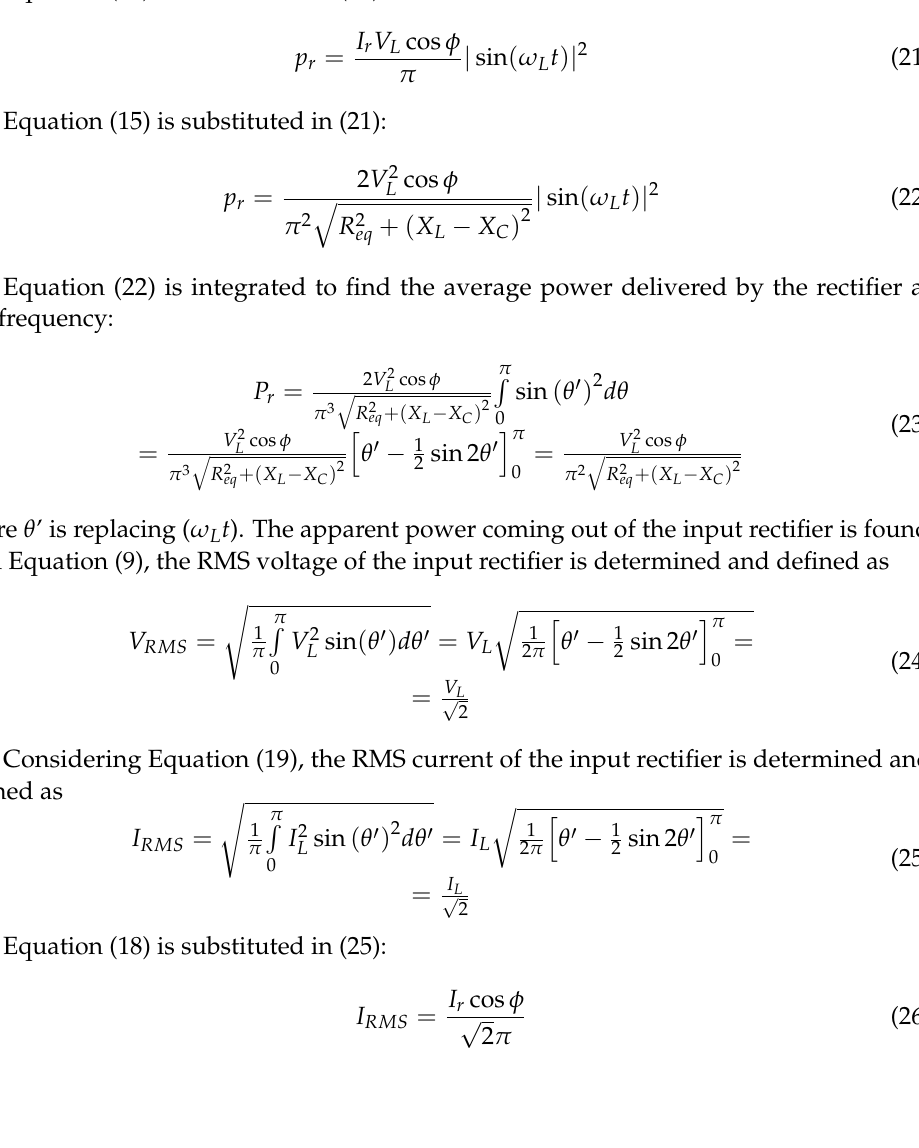
ered by the rectifier at a low frequency, which is defined as Equation (18) is substituted in (20):